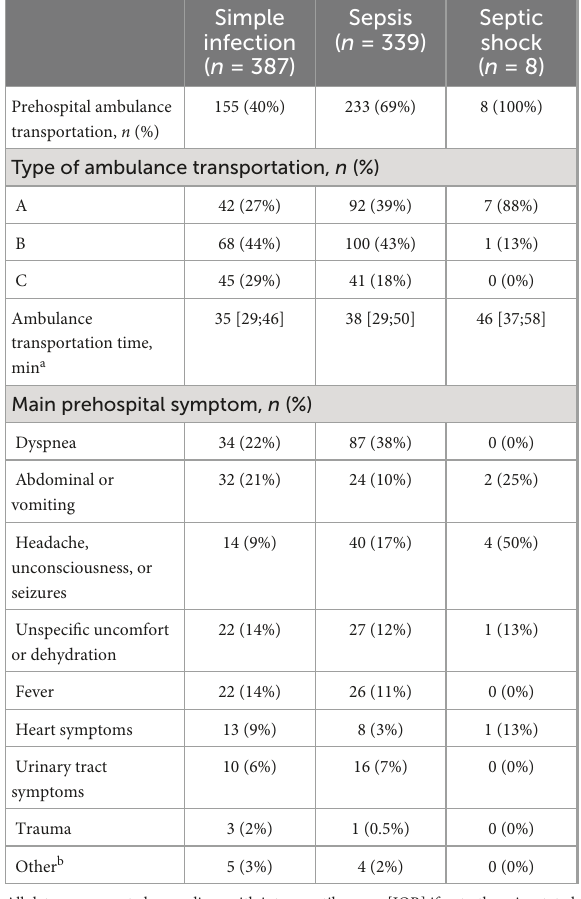
TABLE 3 Prehospital characteristics of patients admitted minimum 24 h with fluids registered. Simple